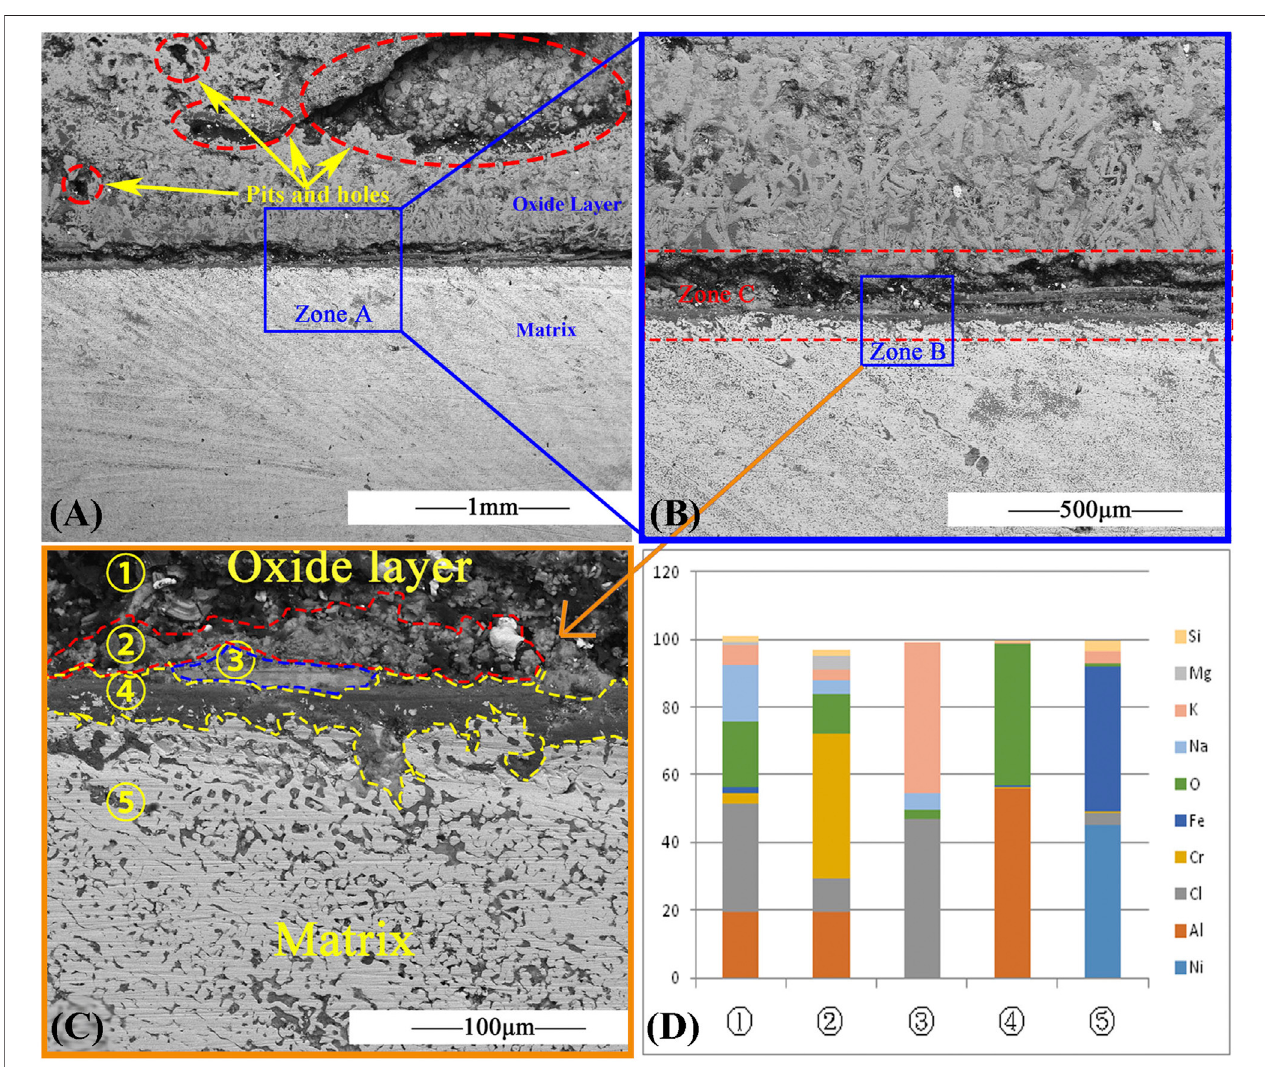
FIGURE6| SEMresultofAFA310Scrosssectionafter120 hat800 ° C: (A) SEMimage, (B) TheareaofbluerectangleZoneAin (A) , (C) Theareaofbluerectangle Zone B in (B) , (D) Element of fi ve layers of AFA 310S cross section